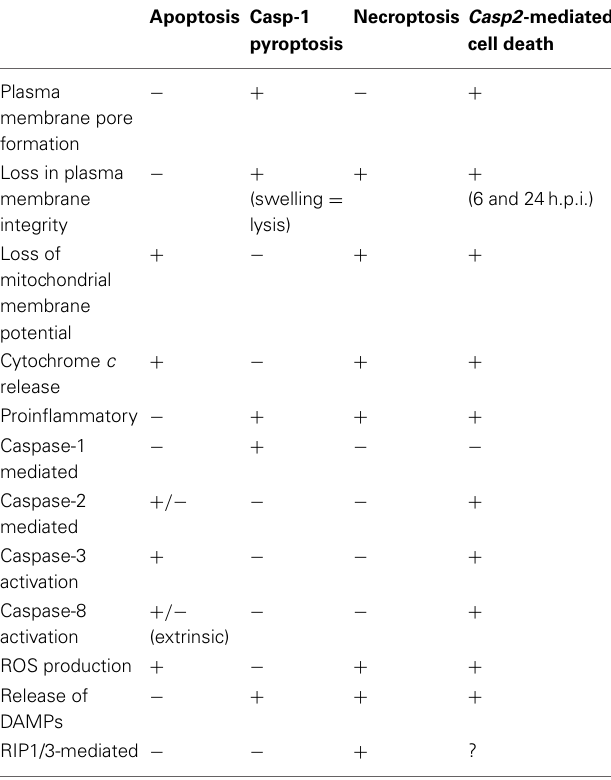
Table 2 | Comparison of caspase-2-mediated cell death to classical apoptosis and